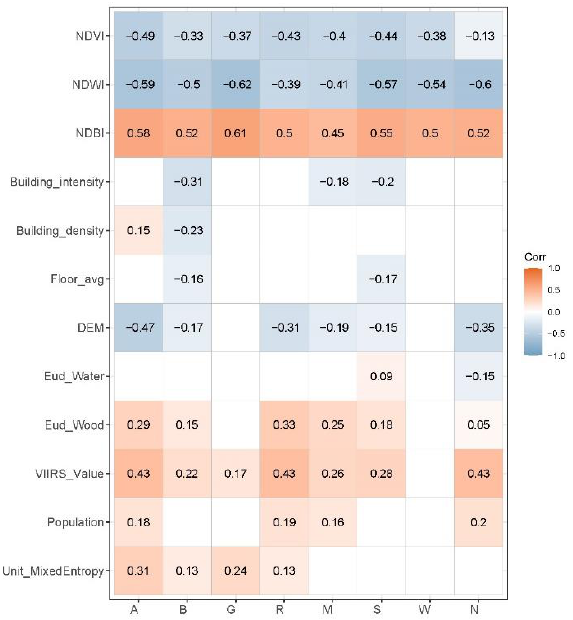
Figure 8. Spearman correlation coefficients of DST with 12 biophysical and social-economic indicators in seven types of functional construction land zones and non-construction areas.